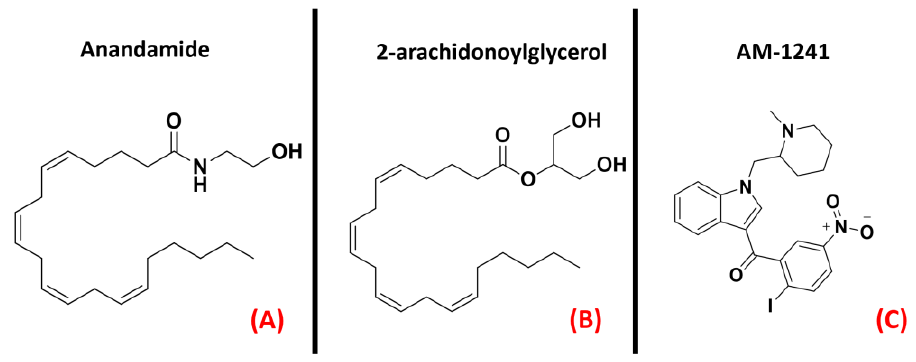
Figure 20. The chemical structures of the endogenous CB 1 and CB 2 receptors agonists anandamide ( A ) and 2-arachidonoylglycerol ( B ). The selective CB 2 receptor agonist AM-1241 is also reported ( C ). In addition to this, Bilsland et al. reported that the knock-out of CB 1 receptors in SOD1 G39A ALS-affected mice had no appreciable effect on disease onset [136], and regard-